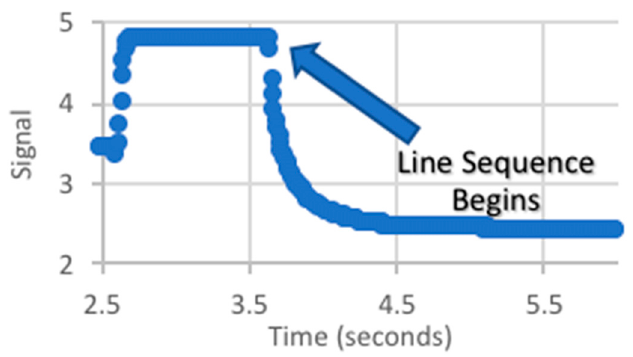
Figure 12. Signal (V) at the beginning of line sequence.